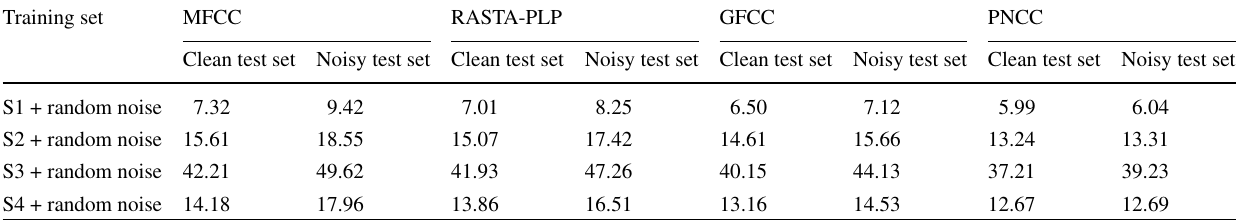
Table 4 WER obtained on noise augmented train set using varying front-end approaches Training set MFCC RASTA-PLP GFCC PNCC